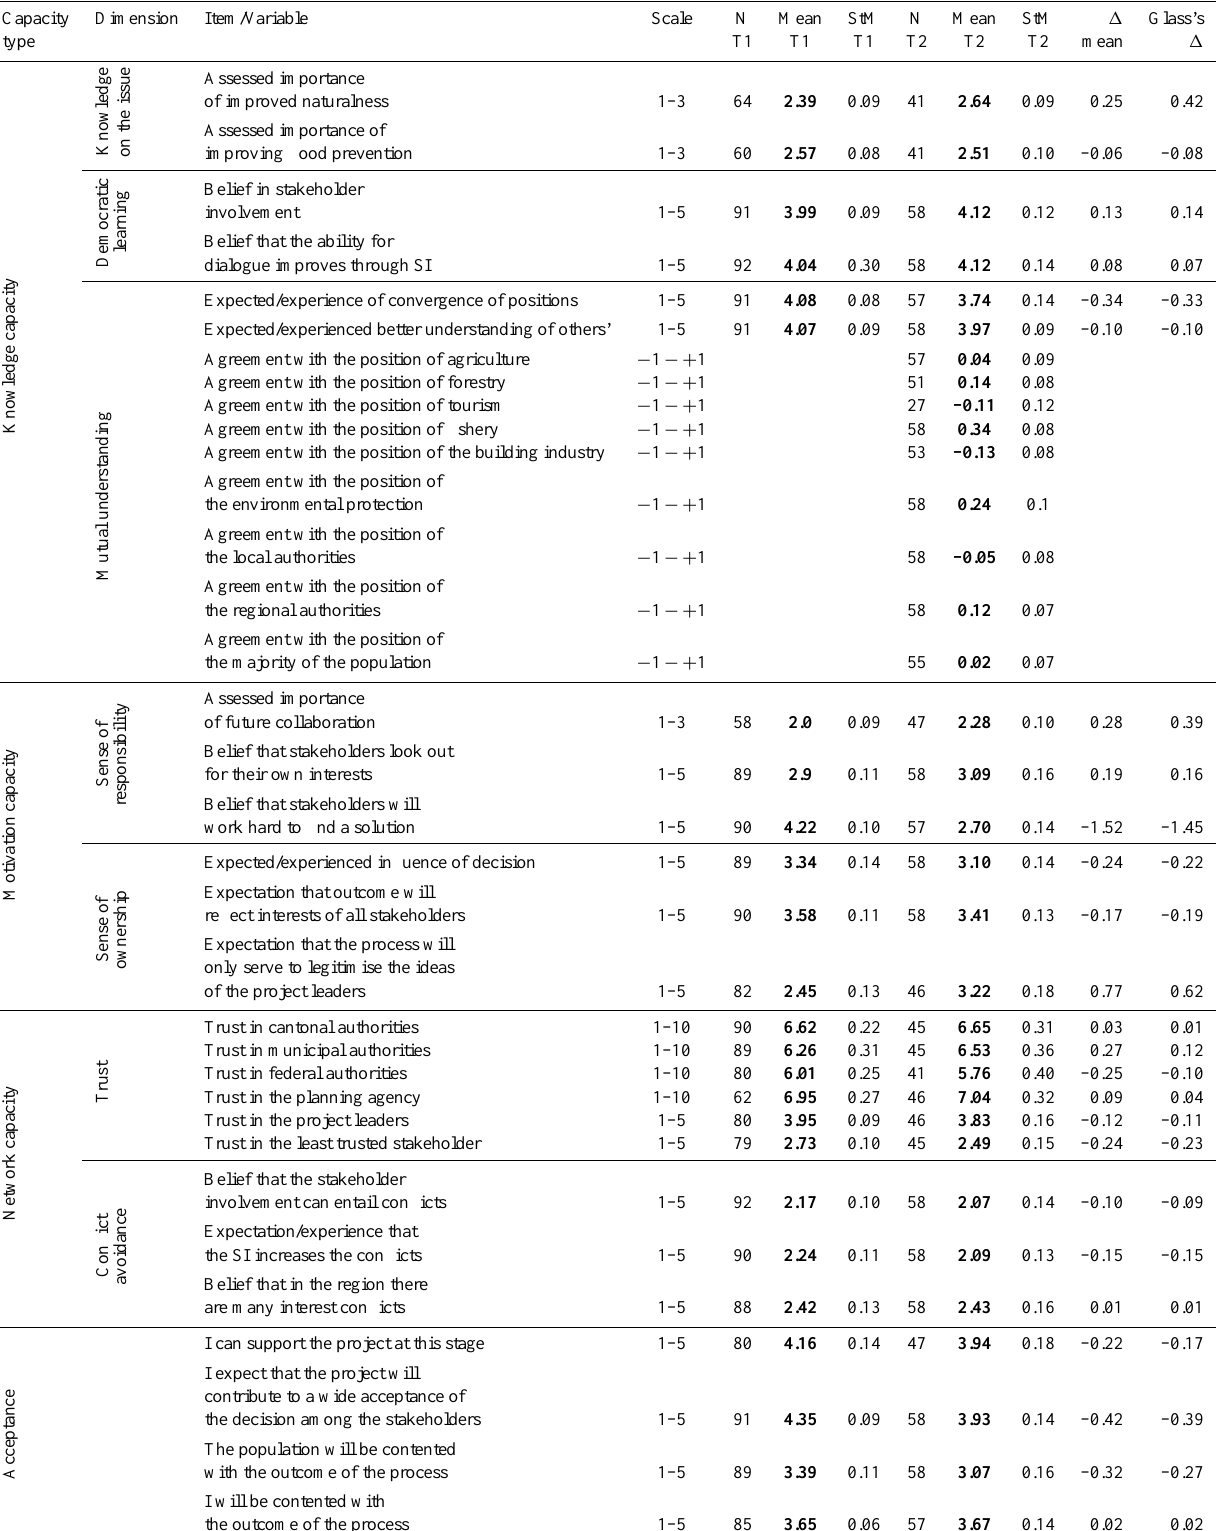
Table 1. The respondents’ perceived social capacities and acceptance of the project in the early (T1) and later (T2) phase of the stakeholder involvement process. Analysis of means of the full sample. Mean values T1 and T2 are in bold.